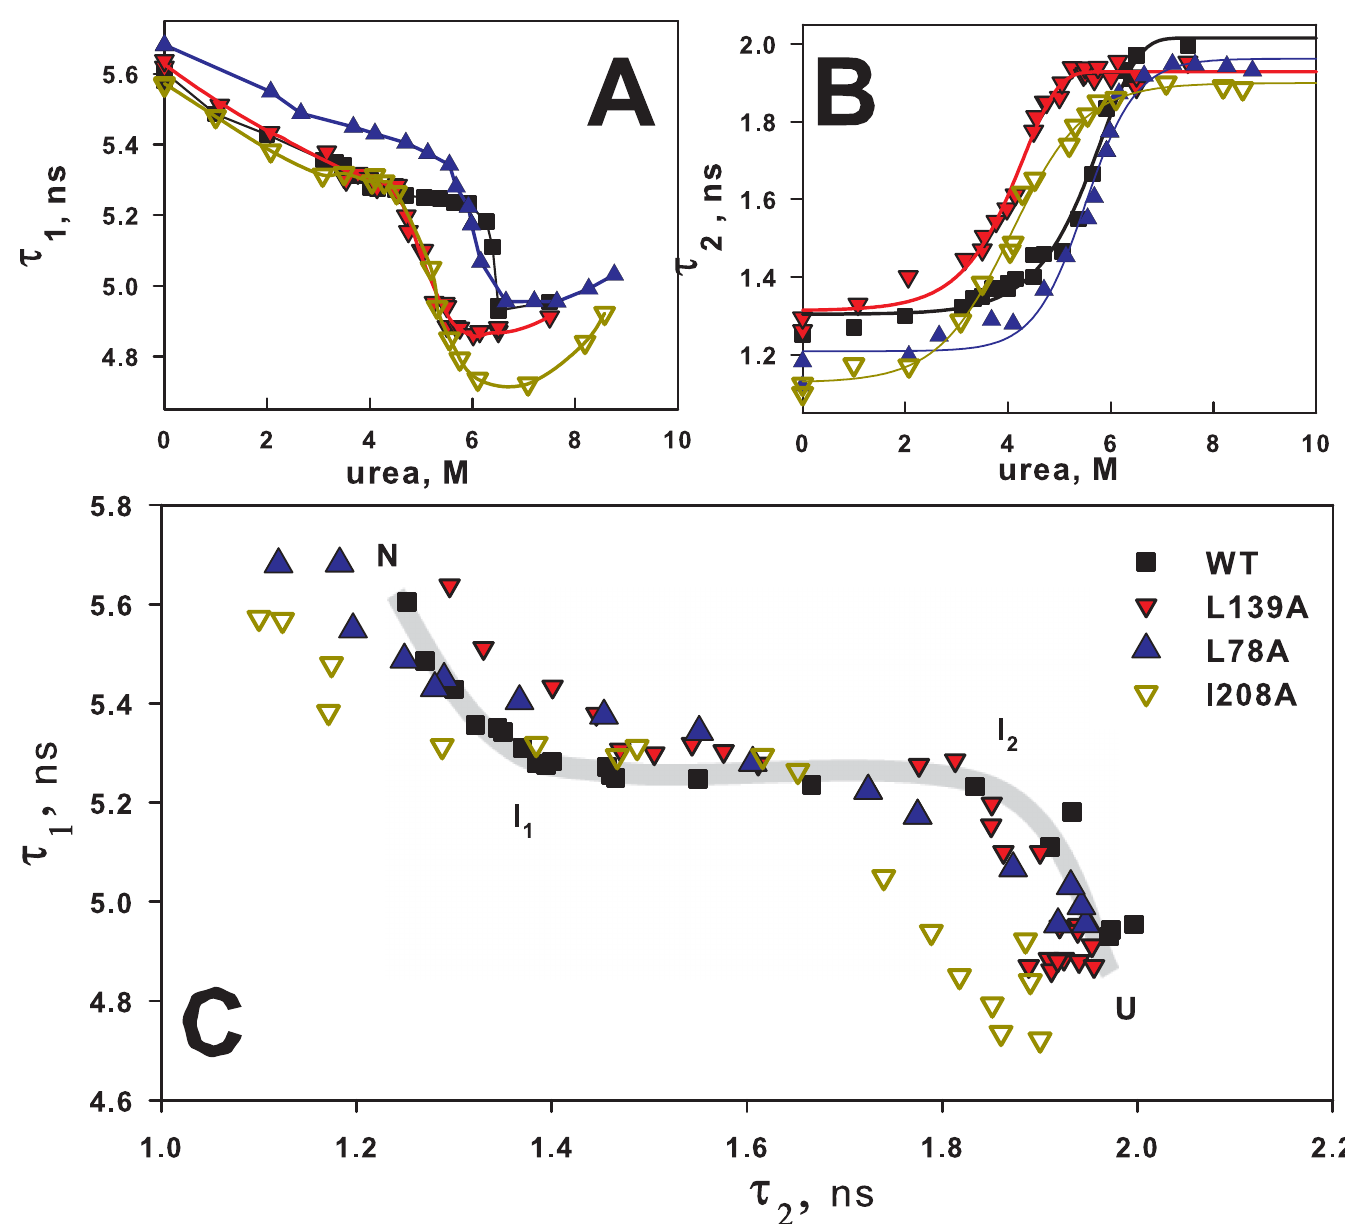
Fig 6. Effect of single substitution of amino acids on BCA II unfolding. Dependence of fluorescence lifetimes τ 1 (A) and τ 2 (B) on urea concentration of wild-type BCA II ( ■ WT) and its three mutant forms L78A ( ▲ ), L139A ( ▼ ), I208A ( 5 ). (C)–interdependence of two fluorescence lifetime components τ 1 and τ 2 of wild-type BCA II and its three single substituted mutant forms. The relative deviations for τ 1 and τ 2 were � 3% and � 7%